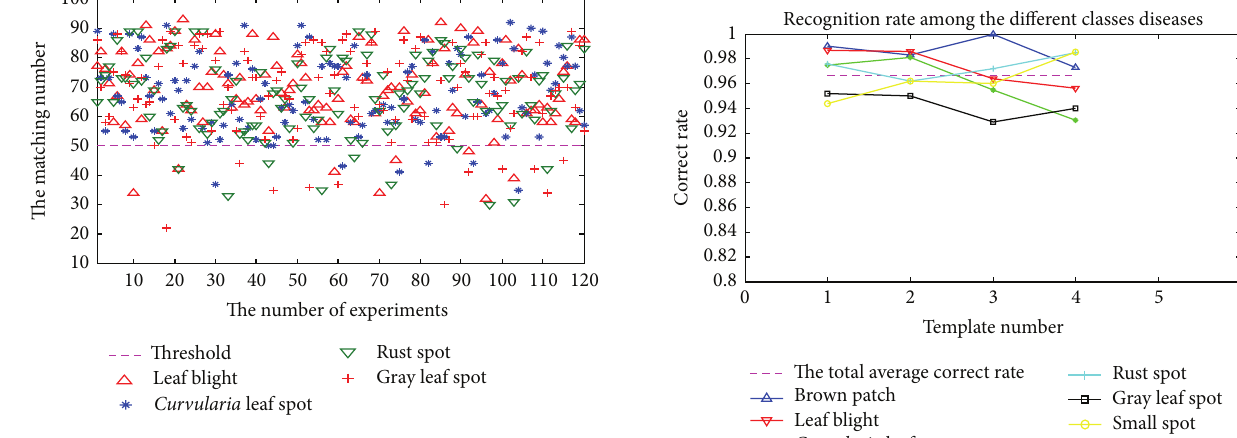
Figure 15: Experiment results between the same diseases.